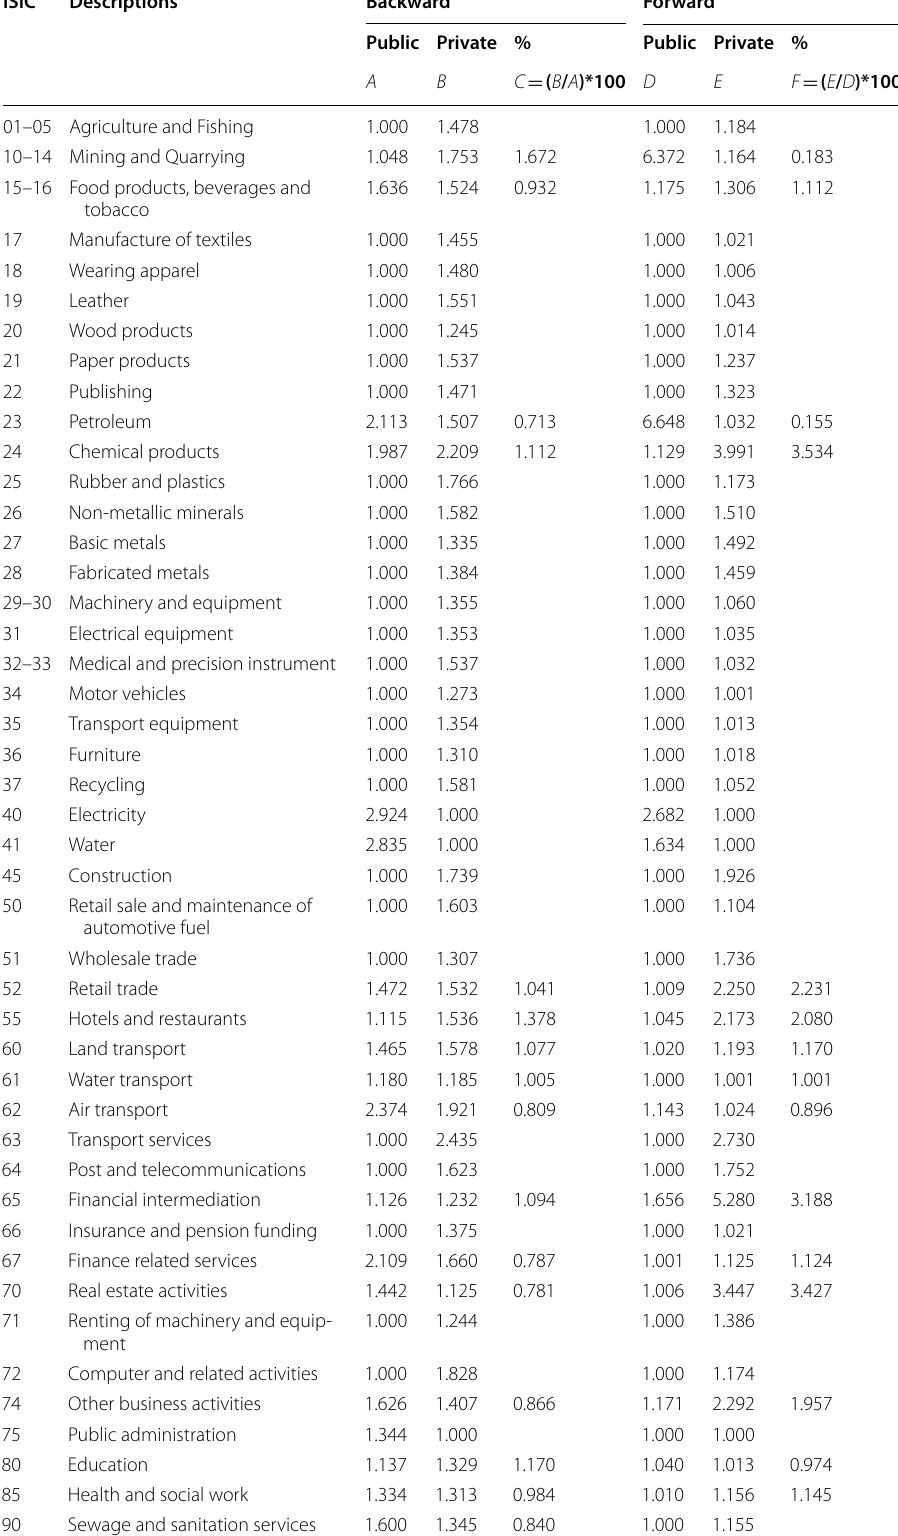
Table 5 Backward and forward linkages. Source: computed by the authors based on CSB (2013)